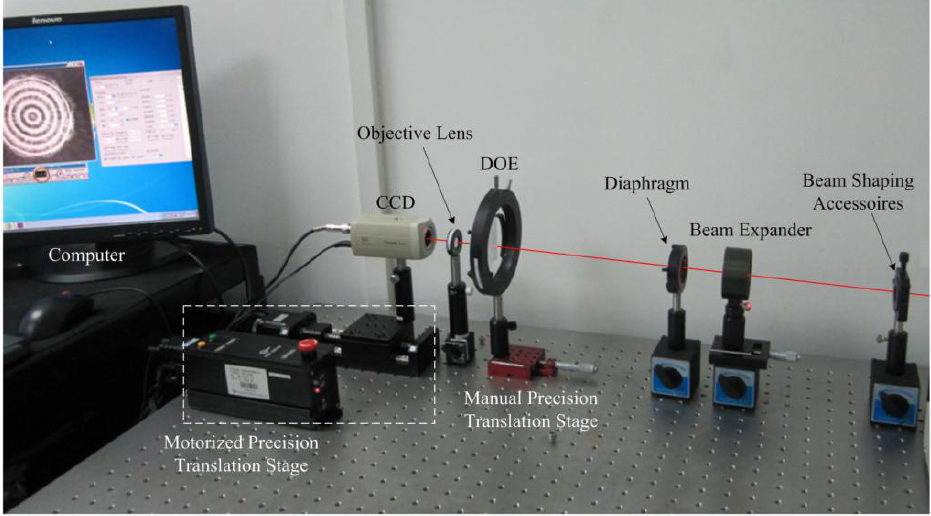
Figure 13. Experiment platform of light path for recording-reading beam.